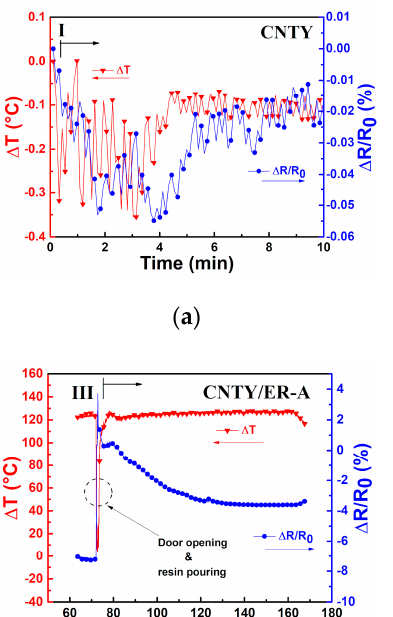
Figure 3. Change in electrical resistance and temperature during the curing resin process of CNTY/ER-A. ( a ) CNTY/ER-A, ( b ) freestanding CNTY under the same temperature program.